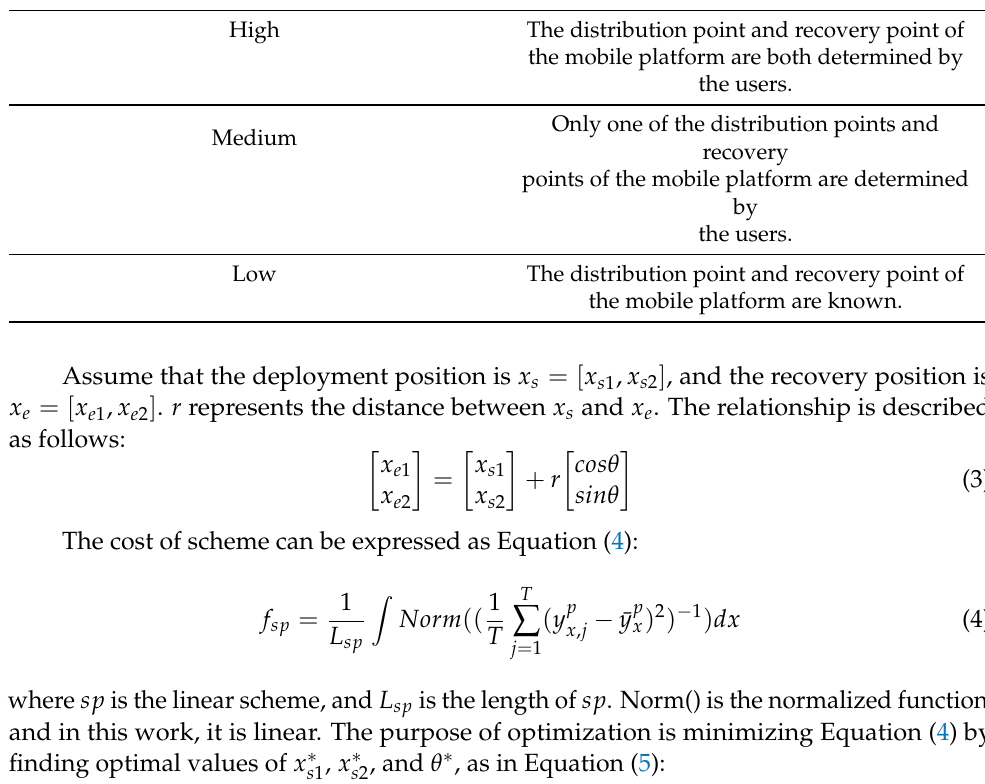
Table 2. Multi-layer nested process of coupled model. Freedom Cases High The distribution point and recovery point of the mobile platform are both determined by the users. Only one of the distribution points and Medium recovery points of the mobile platform are determined by the users. Low The distribution point and recovery point of the mobile platform are